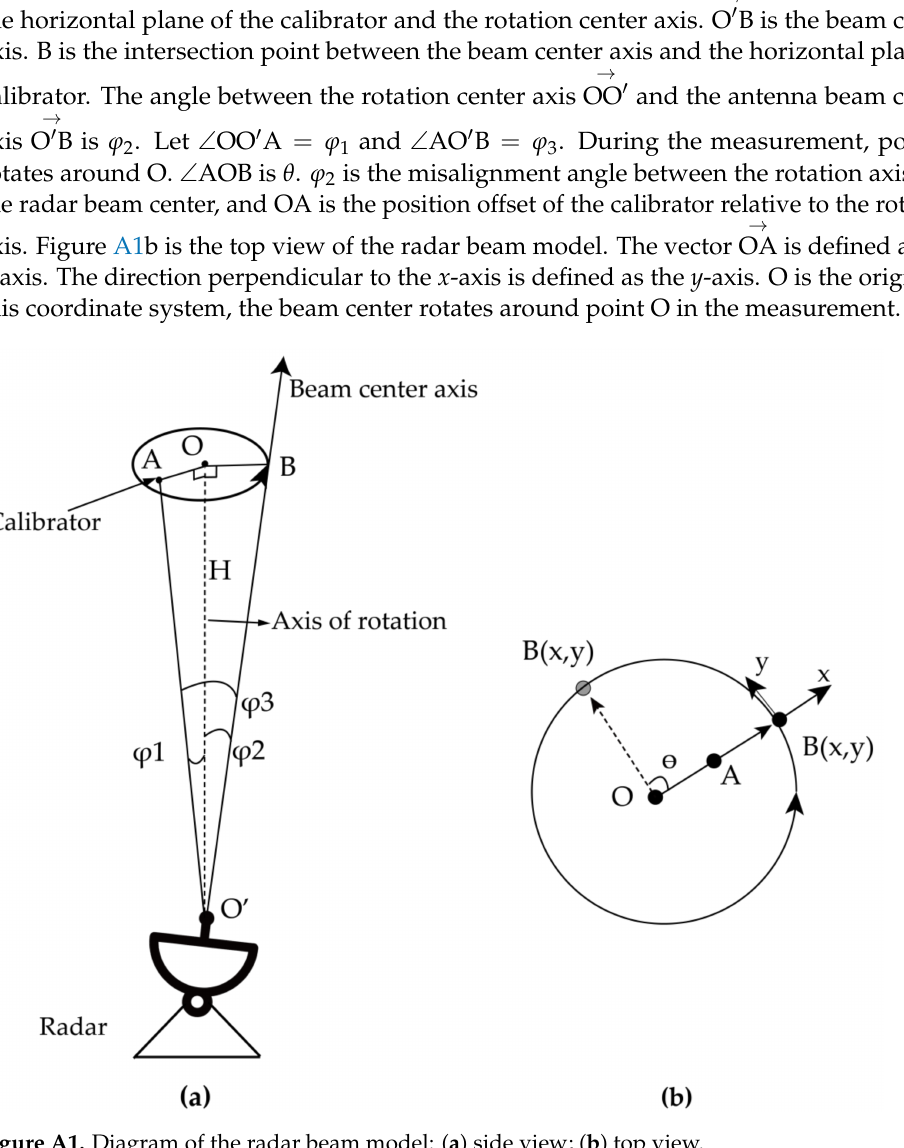
Figure A1. Diagram of the radar beam model: ( a ) side view; ( b ) top